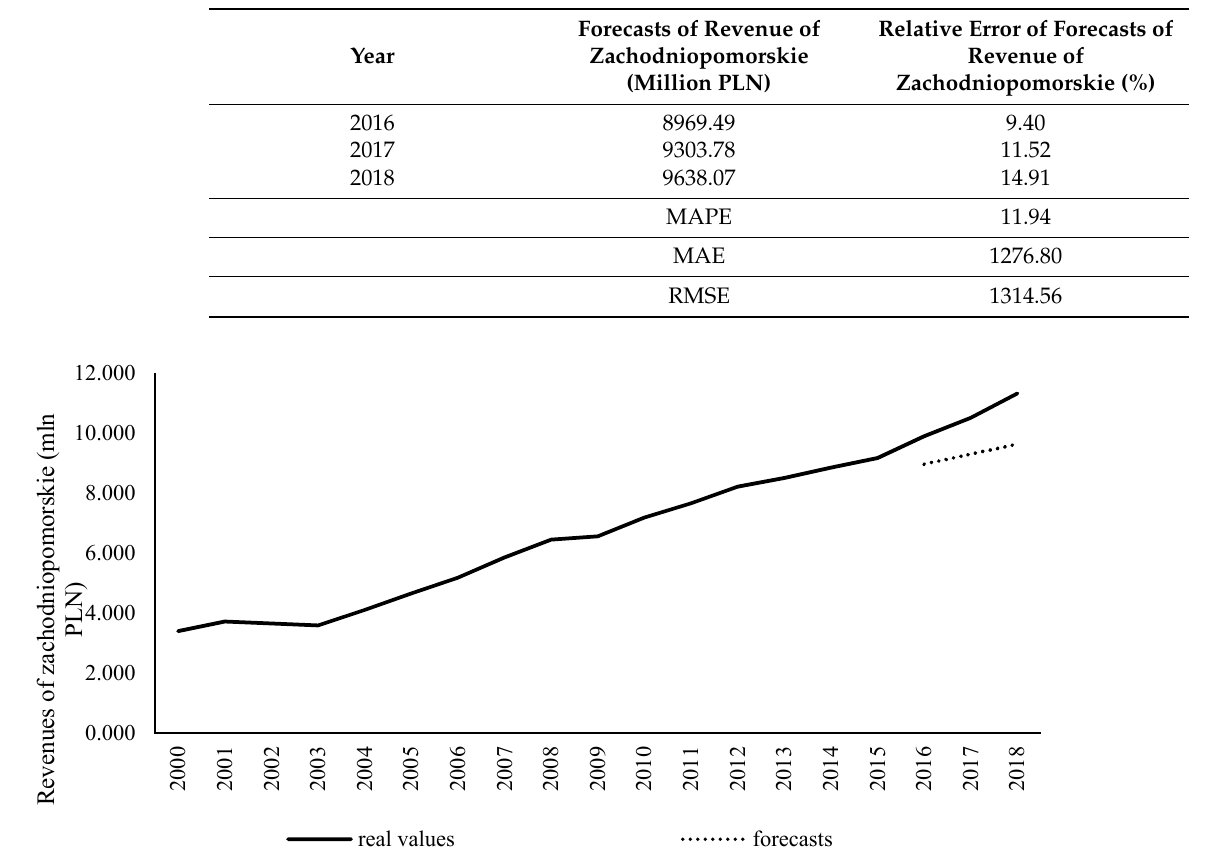
Table 7. Forecasts of revenue and their errors for Zachodniopomorskie (based on model 9 and forecasts of regional gross product based on model 10).